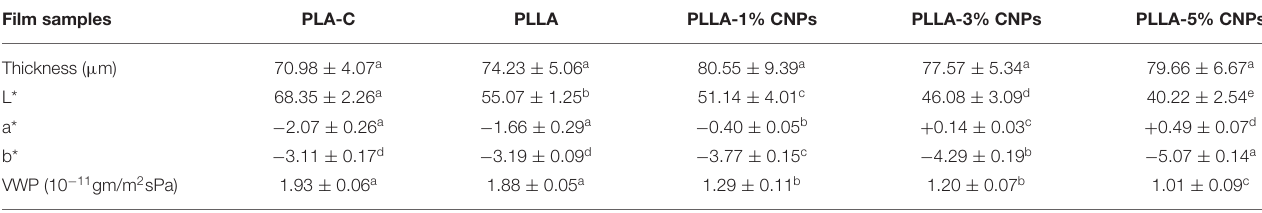
TABLE 2 | Physical properties of poly (L-lactic acid) (PLLA) nanocomposite films, compared to neat PLA and PLLA